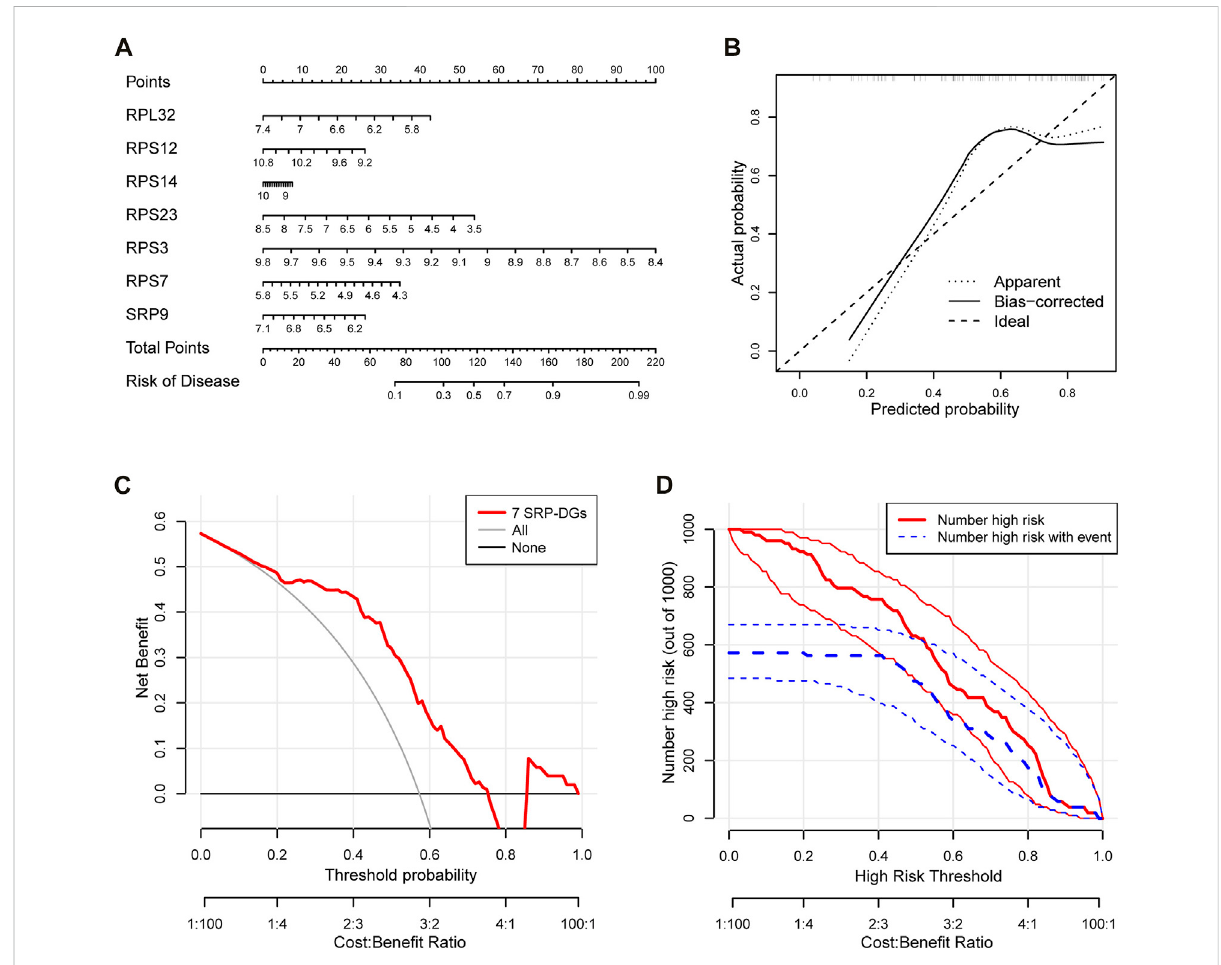
FIGURE 9 ConstructionofanSSc-PHdiagnosticmodelbasedonsevenSRP-DGs. (A) NomogramforpredictingSSc-PHriskbasedonsevenSRP-DGs. (B) The calibration curve showing the accuracy of predicting SSc-PH. (C) The decision curve for analyzing the bene fi ts of the diagnostic model. (D) The clinical impact curve showing the predicted probability of the diagnostic